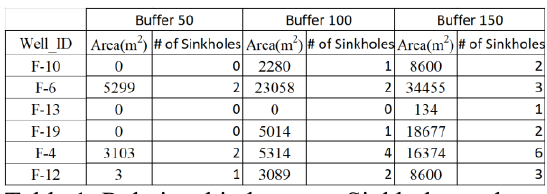
Table 1. Relationship between Sinkholes